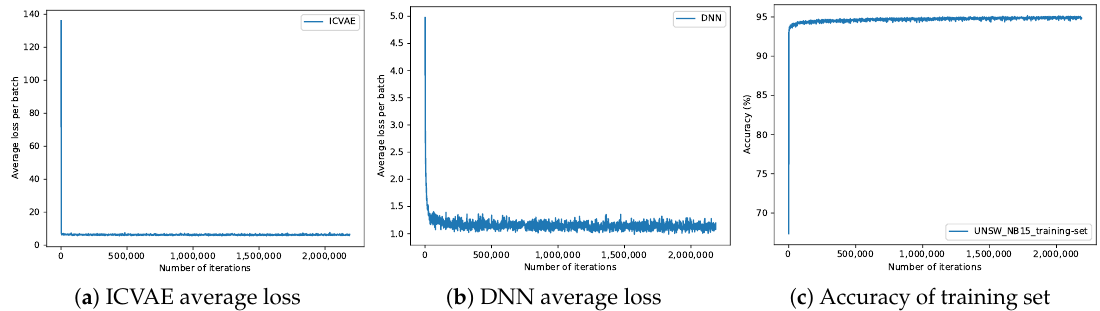
Figure 6. Training charts on the UNSW-NB15 dataset.